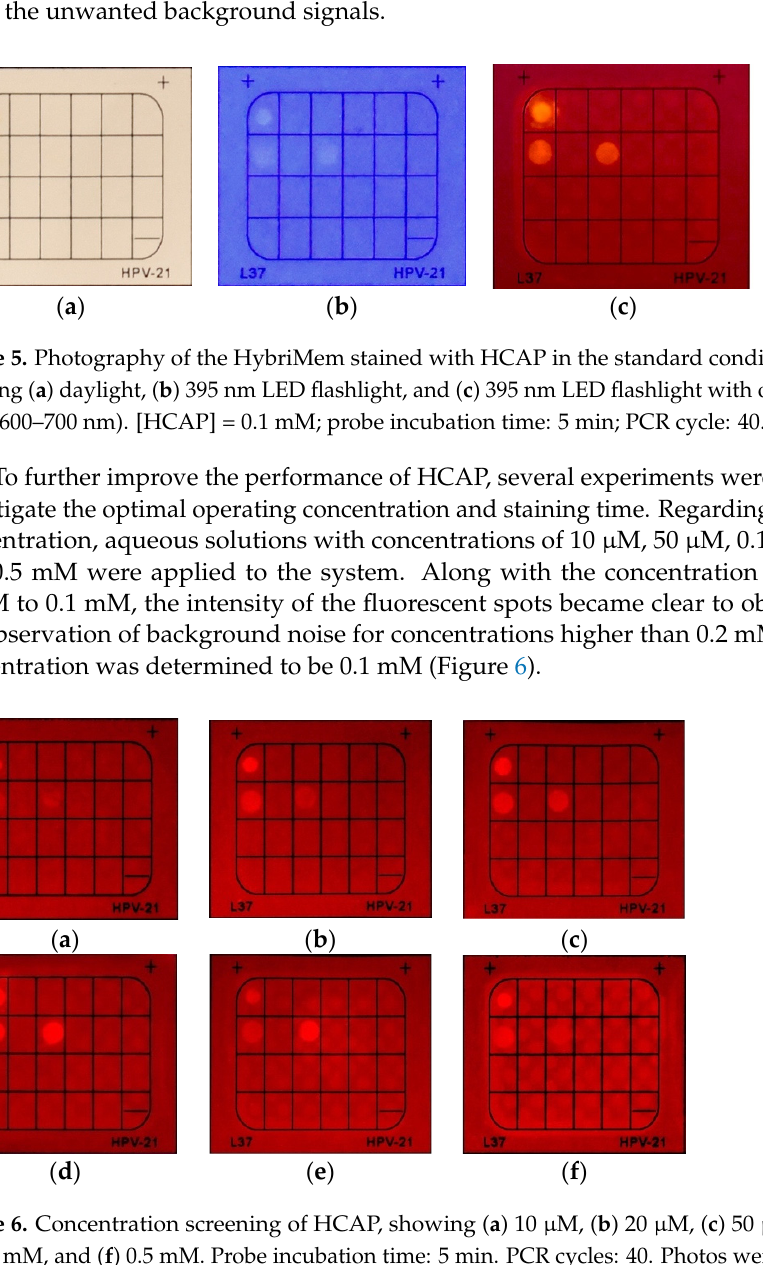
( d ) Figure 7. Result comparisons of HCAP and BCIP/NBT on different incubation times, showing ( a ) 30 s, ( b ) 1 min, ( c ) 2 min, and ( d ) 5 min. [HCAP] = 0.1 mM. PCR cycles: 40. Photos were taken under a 395 nm UV lamp with a band-pass filter 600–700 nm for HCAP, while photos were taken under daylight for BCIP/NBT.